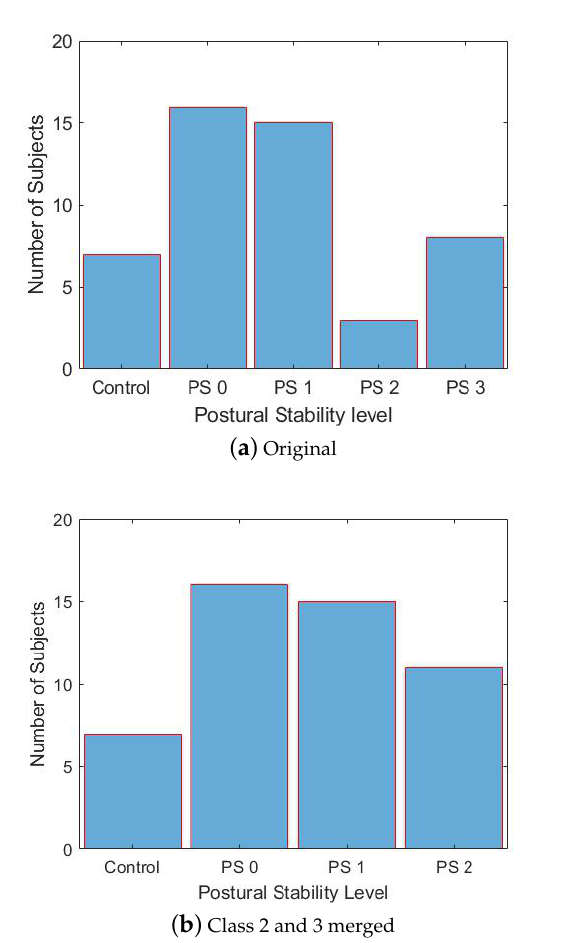
Figure 2. Distribution of subjects based on clinical PS